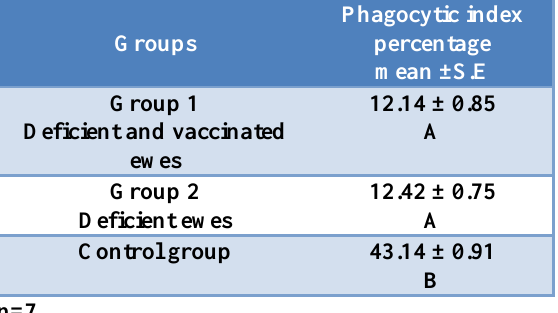
Table 4: The mean percentage of phagocytic activity in ewes (control and vit.E and selenium